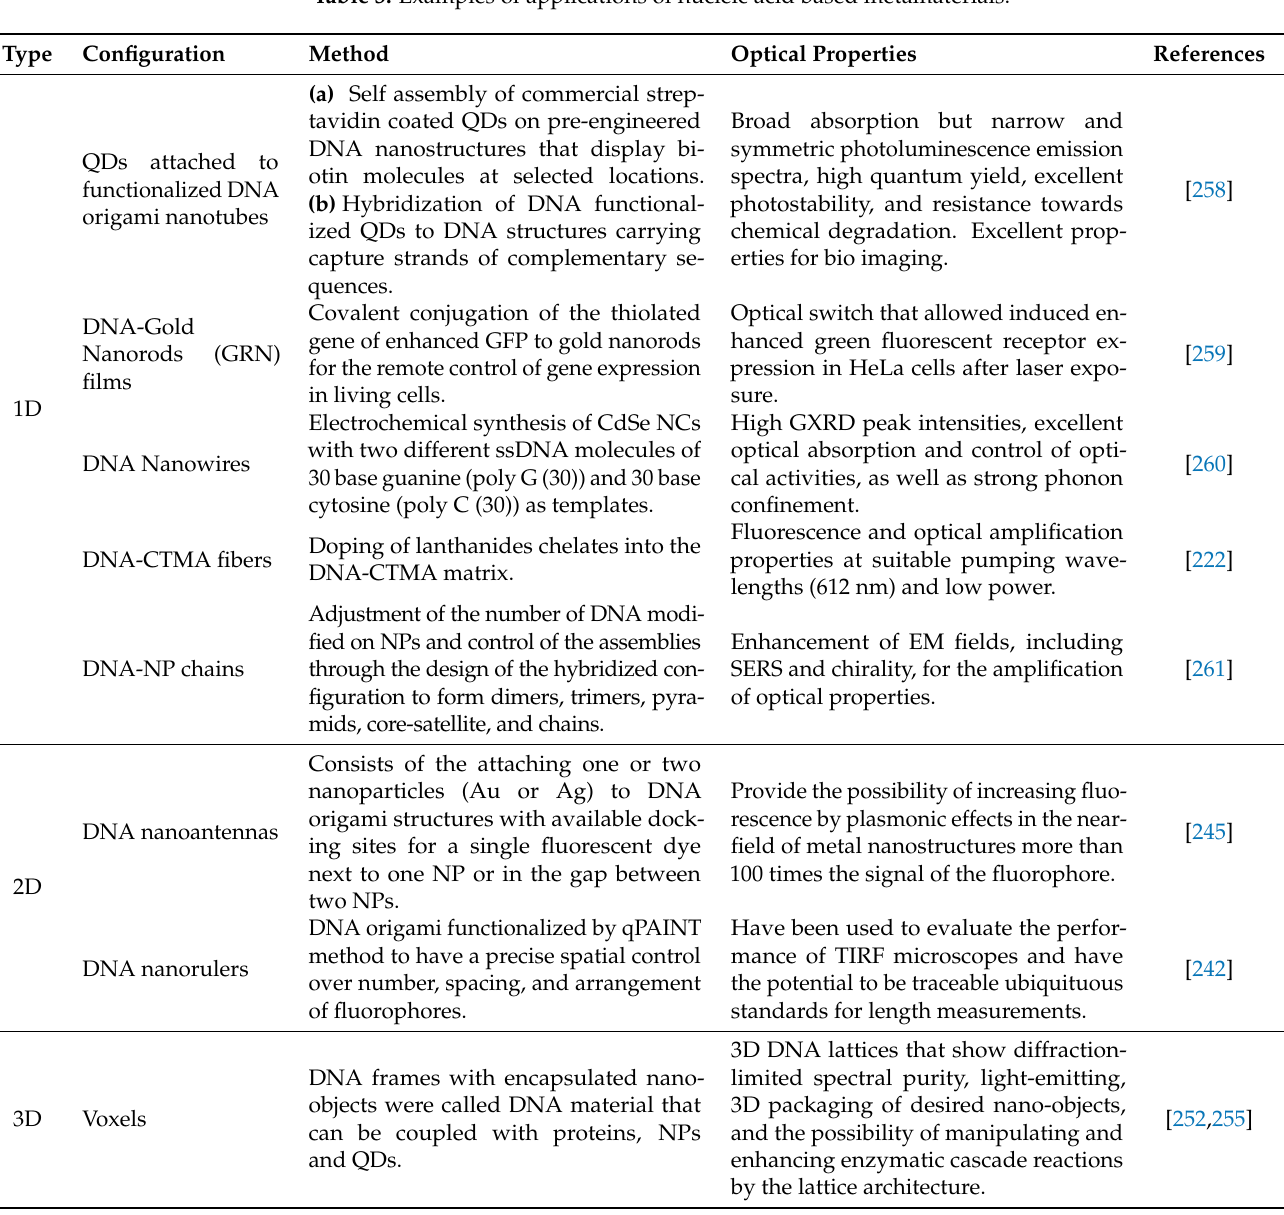
Table 3. Examples of applications of nucleic acid based